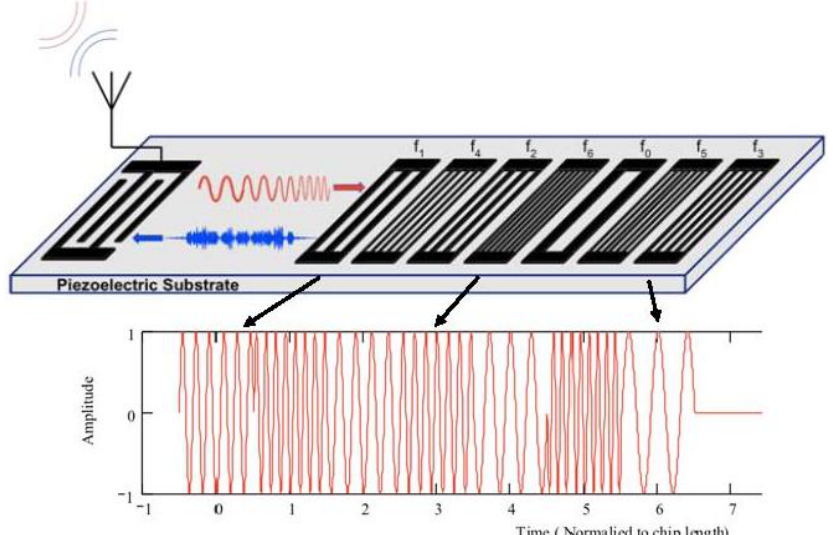
Figure 1. Schematic of a 7 chip SAW OFC RFID tag that can be used as the platform for a sensor. The figure depicts a chirp input time signal and the returned coded signal that is the convolution of the OFC code and chirp input signal. The lower plot depicts the ideal OFC encoded time domain in the Bragg